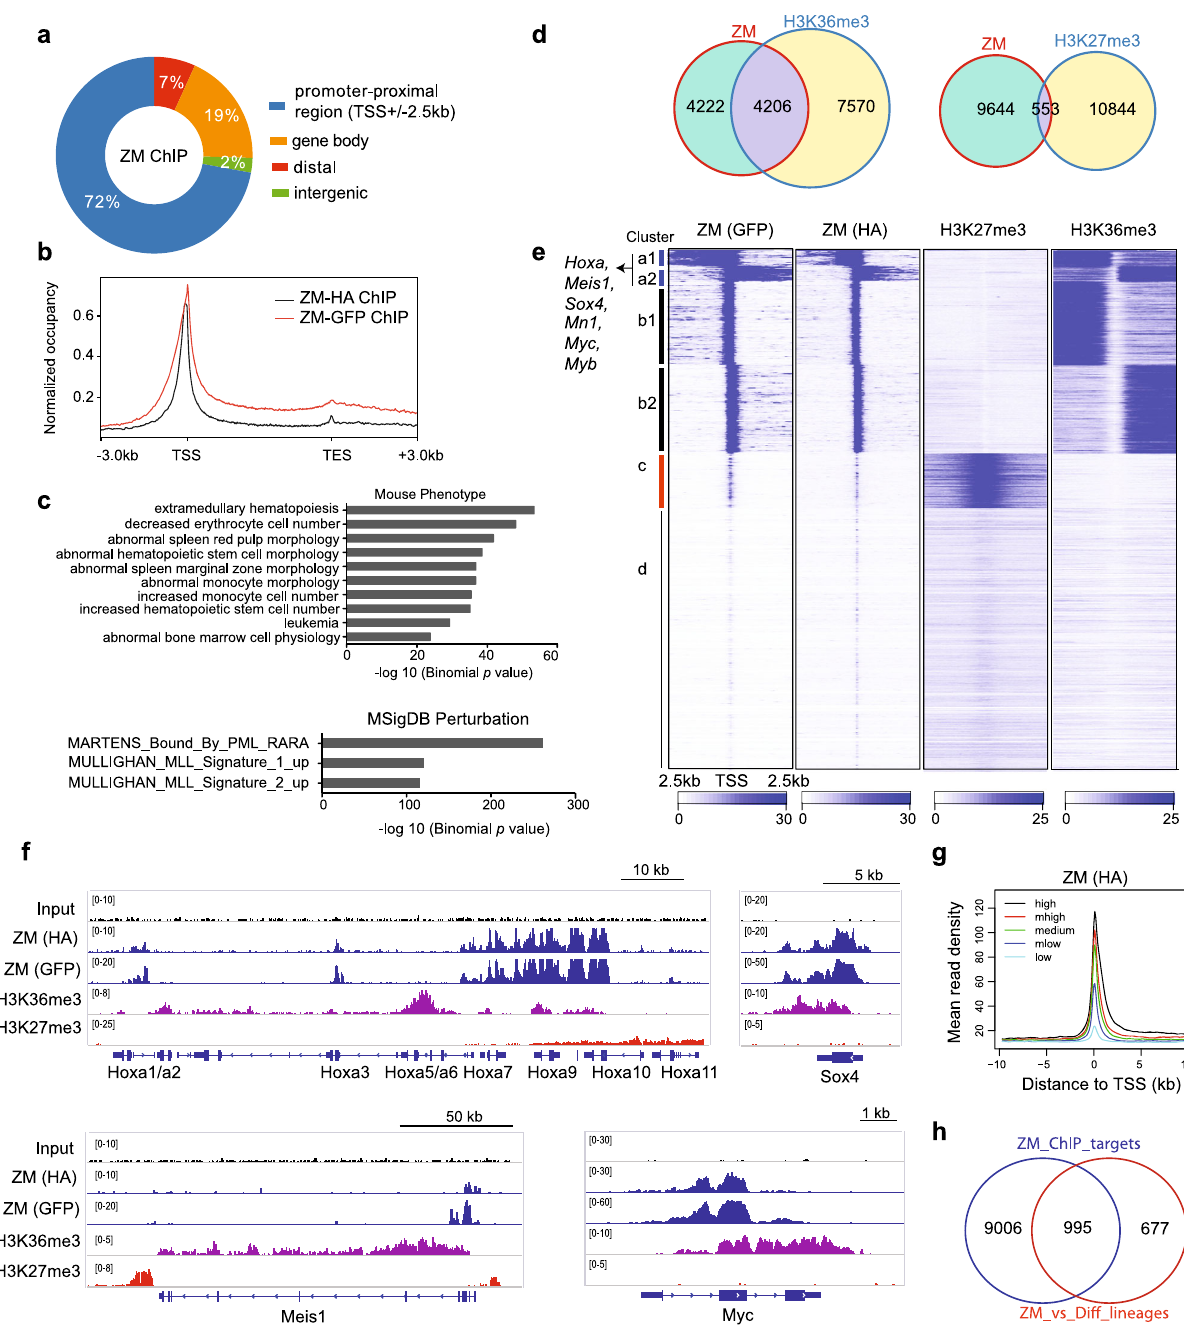
Fig. 3 ChIP-seq reveals positive correlation between ZM binding and transcriptional activation of target genes, including oncogenic transcription factors (TFs) such as Hoxa, Meis1, Myc, Myb and Sox4. a Genomic distribution of ZM peaks ( n = 16,114; common to ZM HA and GFP ChIP) identi fi ed by ChIP-seq in ZM-transformed AML cells. b Average genome-wide ZM occupancy over transcription units, covering region from − 3 kb upstream of transcriptional start site (TSS) to + 3 kb downstream of transcriptional end site (TES). c Genomic Regions Enrichment of Annotations Tool (GREAT) analyses identifying enrichments of the indicated gene signatures among the called ZM peaks ( n = 16,114 peaks). The p value was calculated by binomial test. d Venn diagram displaying overlap between the indicated ChIP-seq peaks in ZM-transformed AML cells. e Heatmaps showing the indicated ChIP-seq read densities over promoter-proximal regions centered at TSS after k-means clustering. Four clusters (labeled as a to d) were produced based on their distinct ZM ChIP-seq signals. TSSs on the two DNA strands are labeled as 1 and 2 (such as a1/2 and b1/2), respectively. f IGV views of the indicated normalized ChIP-seq signals at AML-related proto-oncogene loci. The read counts were fi rst normalized to 1x genome coverage (reads per genome coverage, RPGC) and then normalized to input. g Average ZM ChIP-seq signals at TSSs grouped by gene expression levels as revealed by RNA-seq, indicating a positive correlation. Genes were equally divided into 5 groups from high, medium high ( “ mhigh ” ), medium, medium low ( “ mlow ” ), to low expression. h Venn diagram showing overlap between ZM-activated genes and those directly bound by ZM.